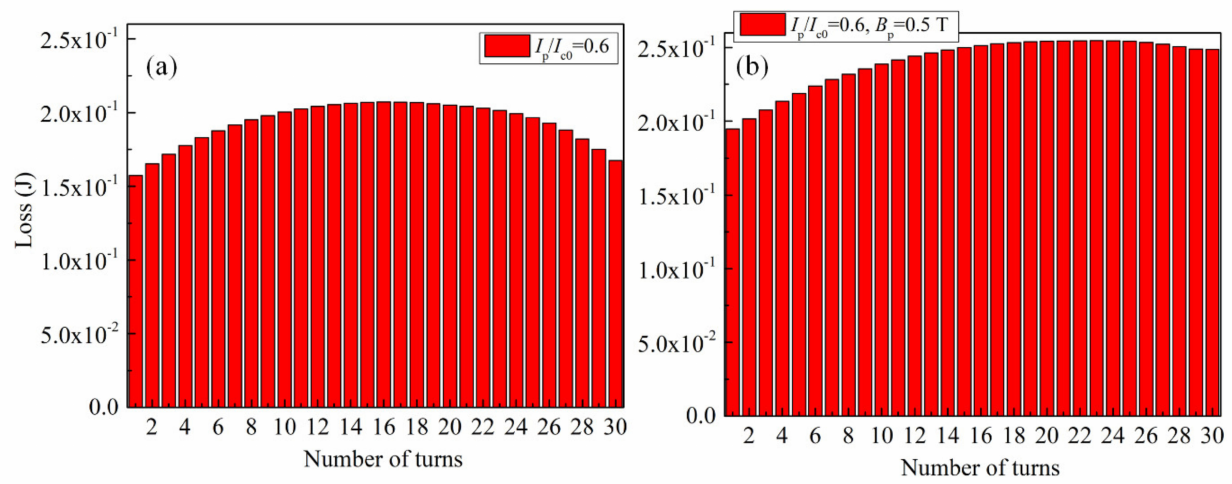
Figure 12. Loss per turn in the coil (( a ) only I p = 0.6 I c0 is transmitted; ( b ) I p = 0.6 I c0 , the external magnetic field waveform is a sine wave, and the magnitude is B p = 0.5